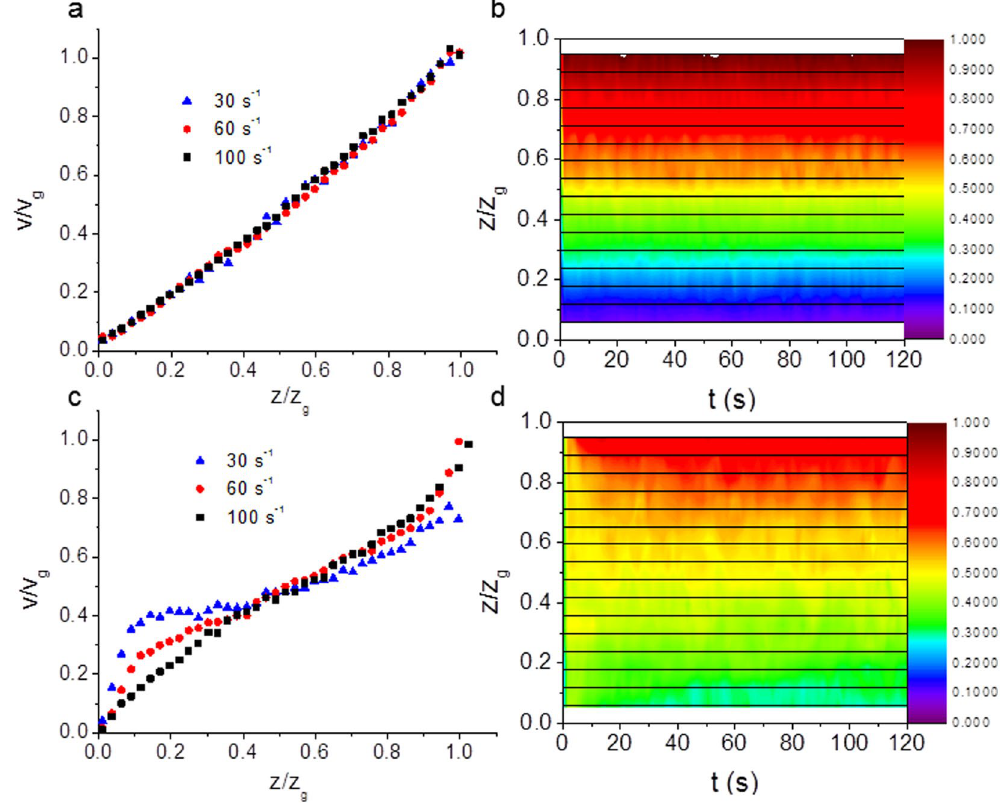
Figure 1. ( a ) Normalized shear velocity ( v / v g ) as a function of normalized distance across the rheometer gap ( z / z g ) for a 5 mg/ml solution of DNA (high salt) at three different steady shear rates which show linear Newtonian-like behavior i.e. a constant velocity gradient. ( b ) A colour map of shear normalized velocity of the same solution as a function of the normalized distance across the rheometer gap and the time after shear start-up at a constant shear rate of 60 s − 1 . The velocity profiles demonstrate a stable steady state. The horizontal lines show the depths at which measurements were made and the colour scale is normalized to the top plate velocity. Similar data for 10 mg/ml solutions of DNA (high salt) are shown in ( c ) and ( d ), with all of the velocity profiles showing significant wall slip. Some strain localization at the boundaries is also seen at all shear rates in ( c ). Using the colour map scale, wall slip is identified by the wide yellow/green region, which is particularly clear when ( d ) is compared to ( b